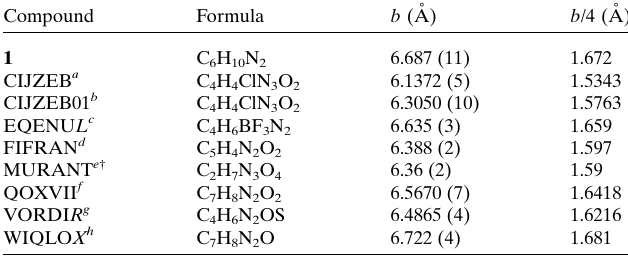
Table 3 Other structures showing the same motif as 1 ; r vdW (C) = 1.7 A˚ ; r vdW (N) = 1.55 A˚ (Batsanov, 1995).